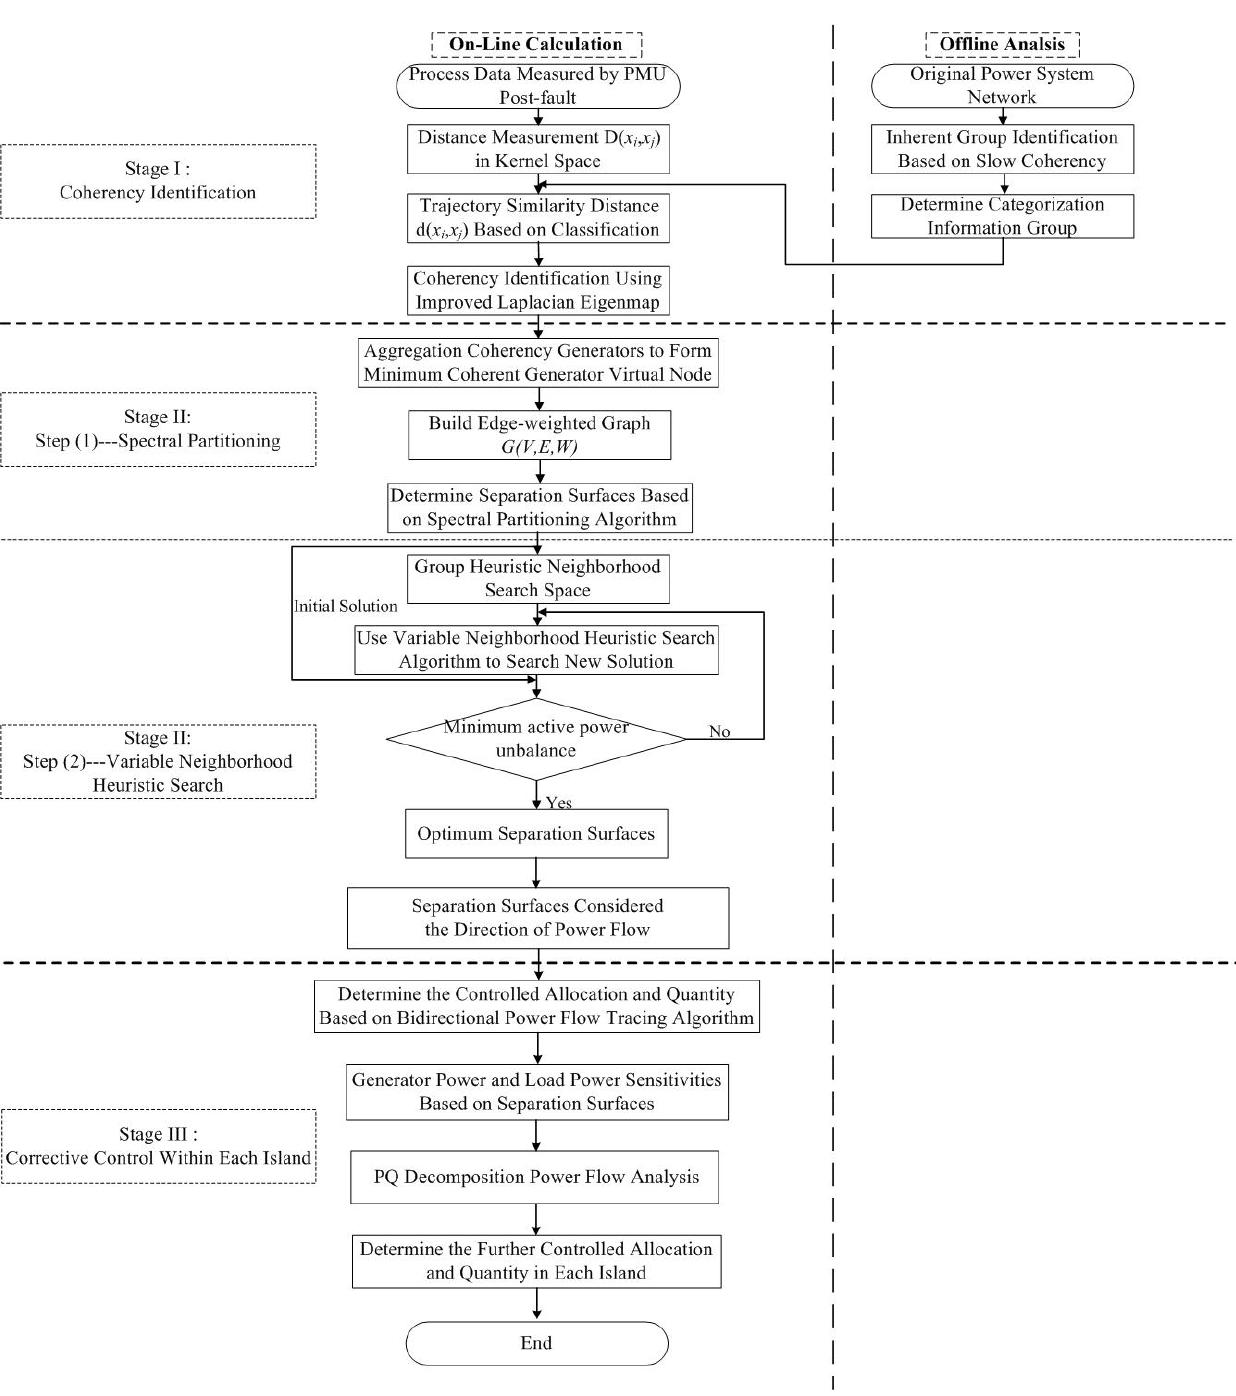
Figure 3. Flow chart of the proposed integrated adaptive controlled islanding strategy. PMU: phasor measurement